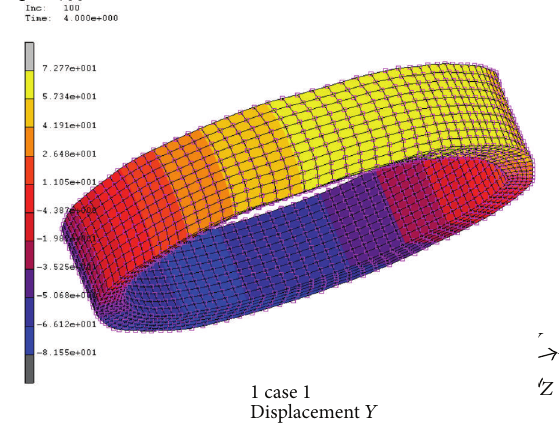
Figure 2: Bimetallic bush outer vertical displacement distribution.